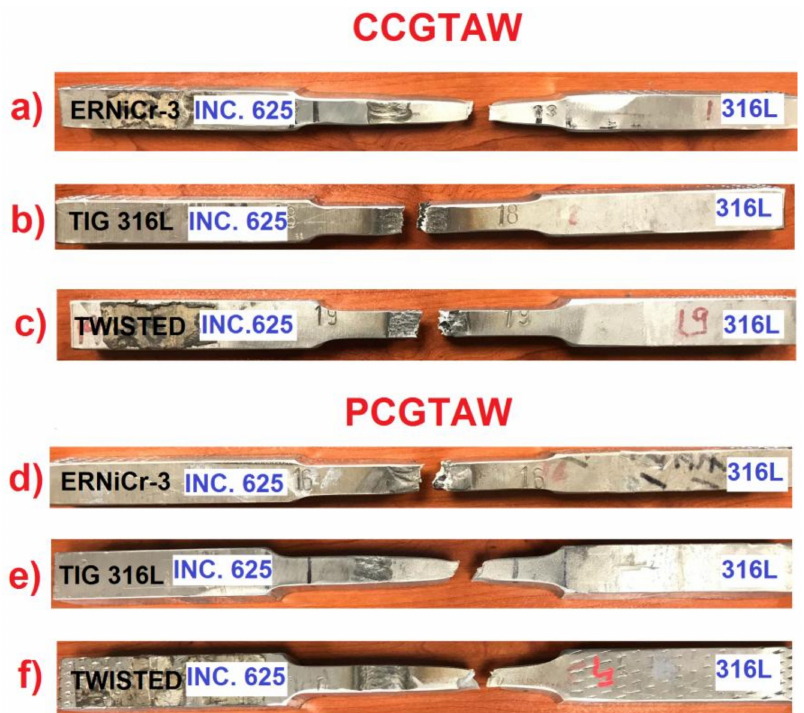
Figure 11. Tensile test results CCGTAW employing ERNiCr-3 ( a ), TIG 316L ( b ), Twisted Filler ( c ), and PCGTA welding employing ERNiCr-3 ( d ), TIG 316L ( e ), Twisted Filler ( f ).